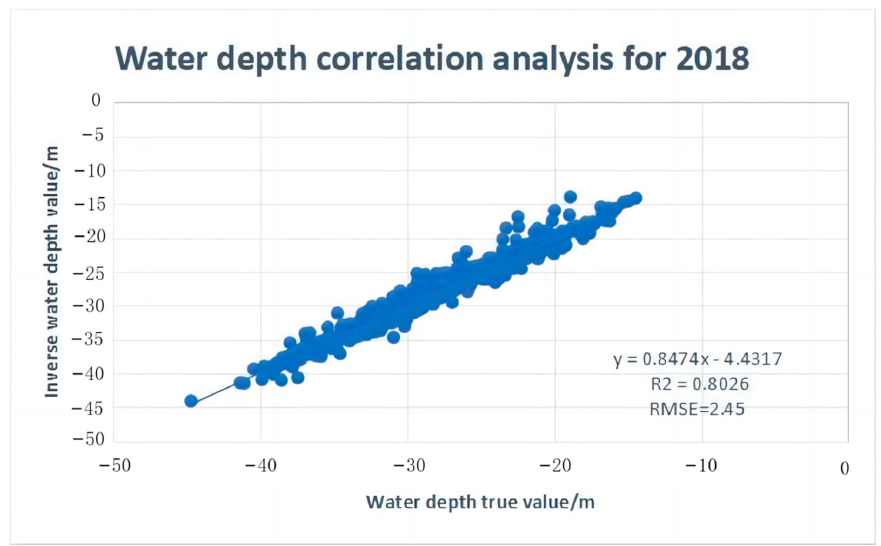
Figure 12. Water depth correlation analysis for 2018.